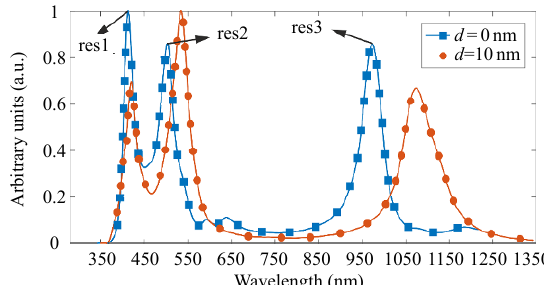
Fig. 2 Resonance peaks of the proposed structure without pressure ( d = 0 nm) and under pressure ( d = 10